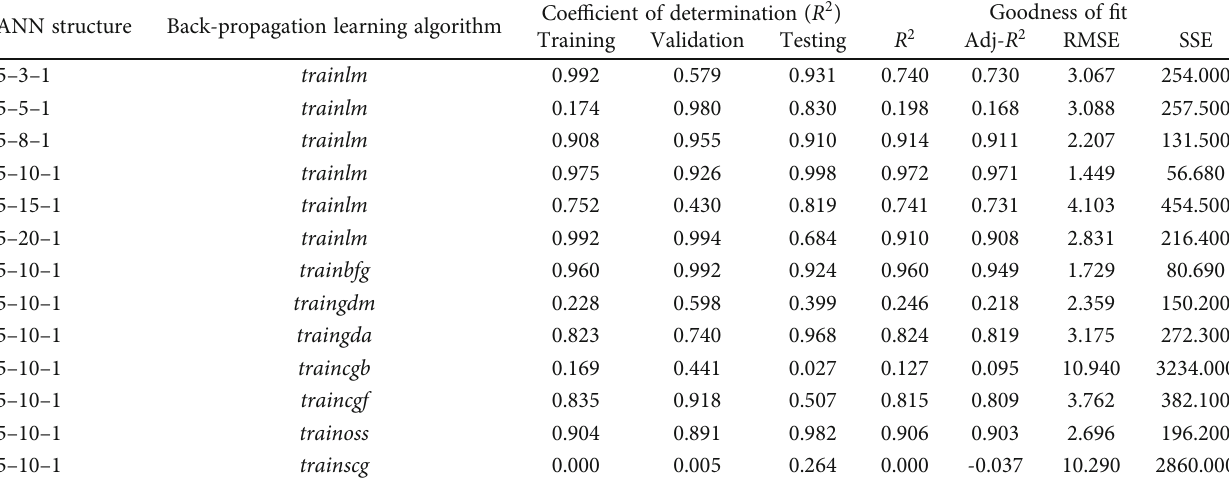
Table 4: Determining the best ANN predictive performance by adapting the number of hidden layer neurons and the back-propagation learning